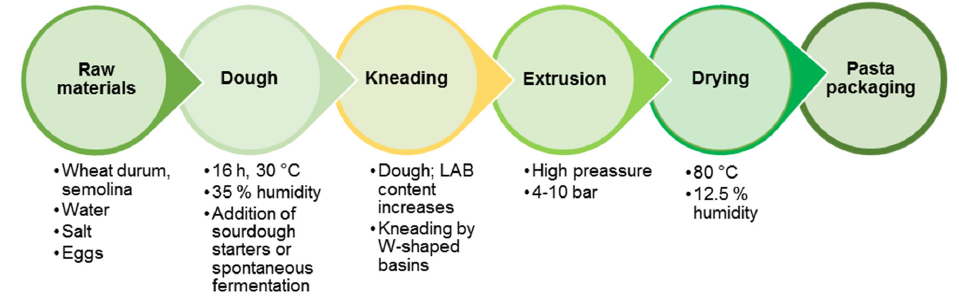
Figure 5. Flowchart of traditional pasta manufacturing.